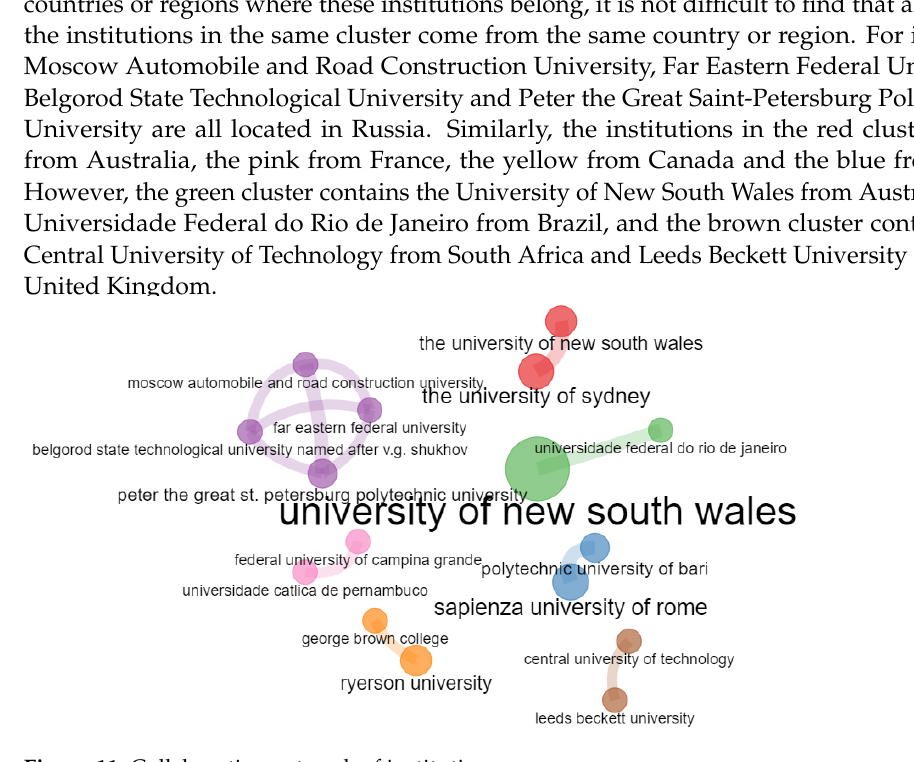
Figure 10. Co-citation network of journals.